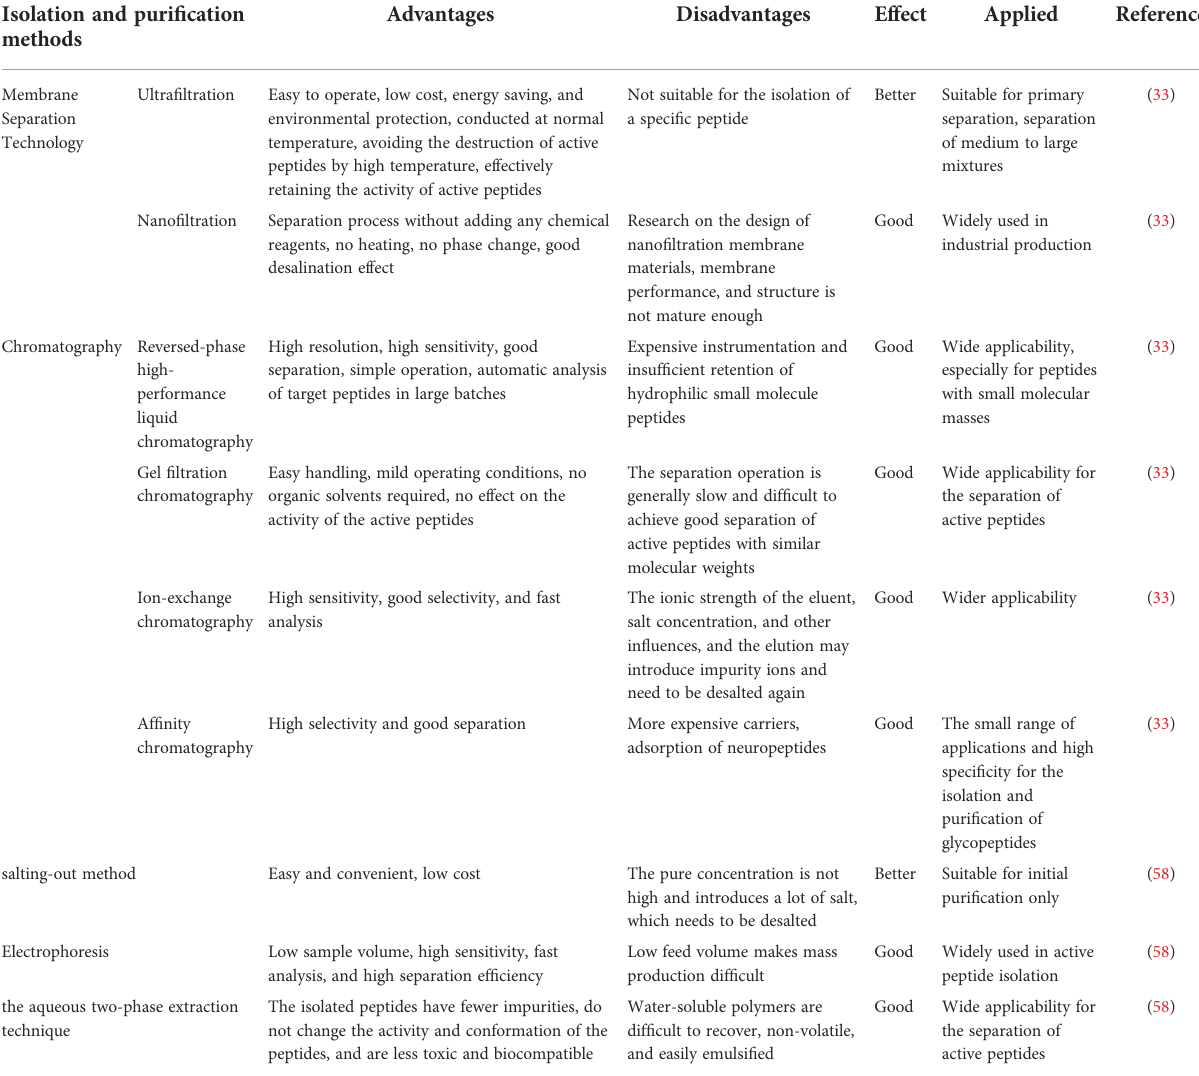
TABLE 5 Classi fi cation and characteristics of peptide isolation and puri fi cation methods. Isolation and puri fi cation